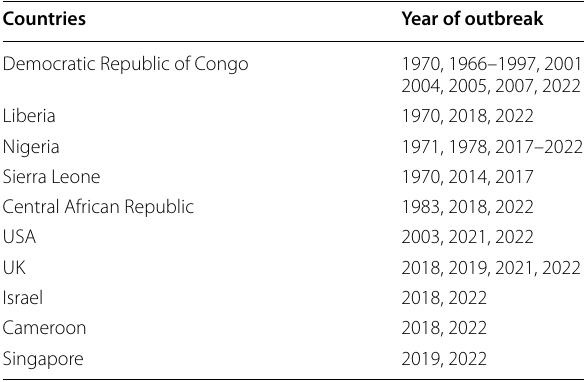
Table 1 Countries with past and present monkeypox outbreaks